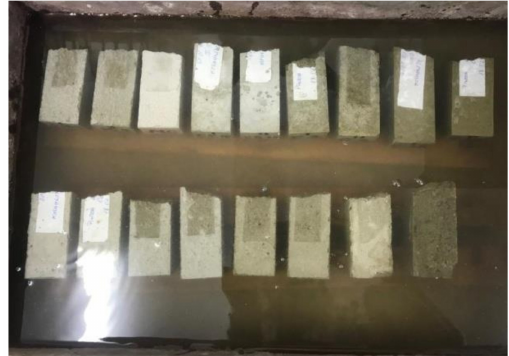
Figure 2. Fully water-soaked specimens.